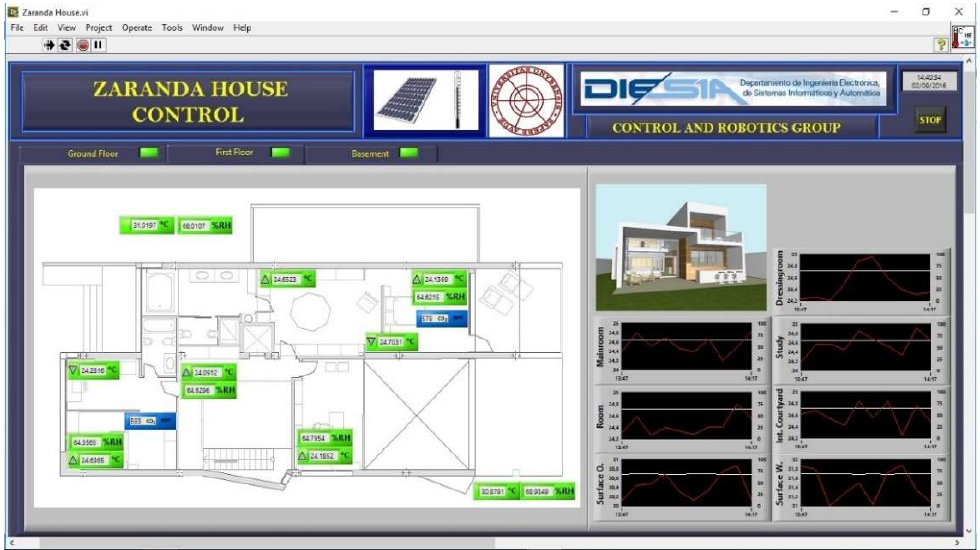
Figure 14. Location of sensors (T, RH, and CO 2 ) on the upper floor.